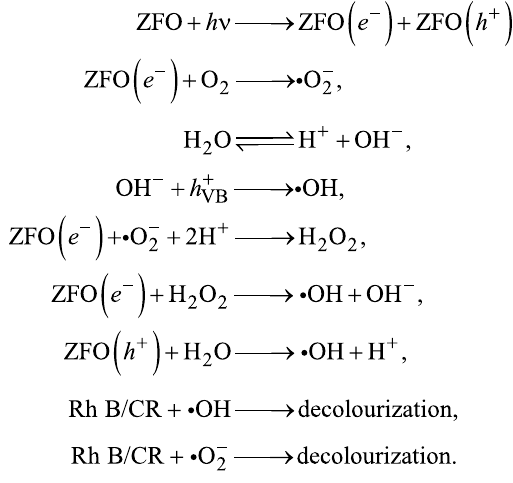
( − 0.046 eV vs NHE) [36]. Hence, electrons from the CB of